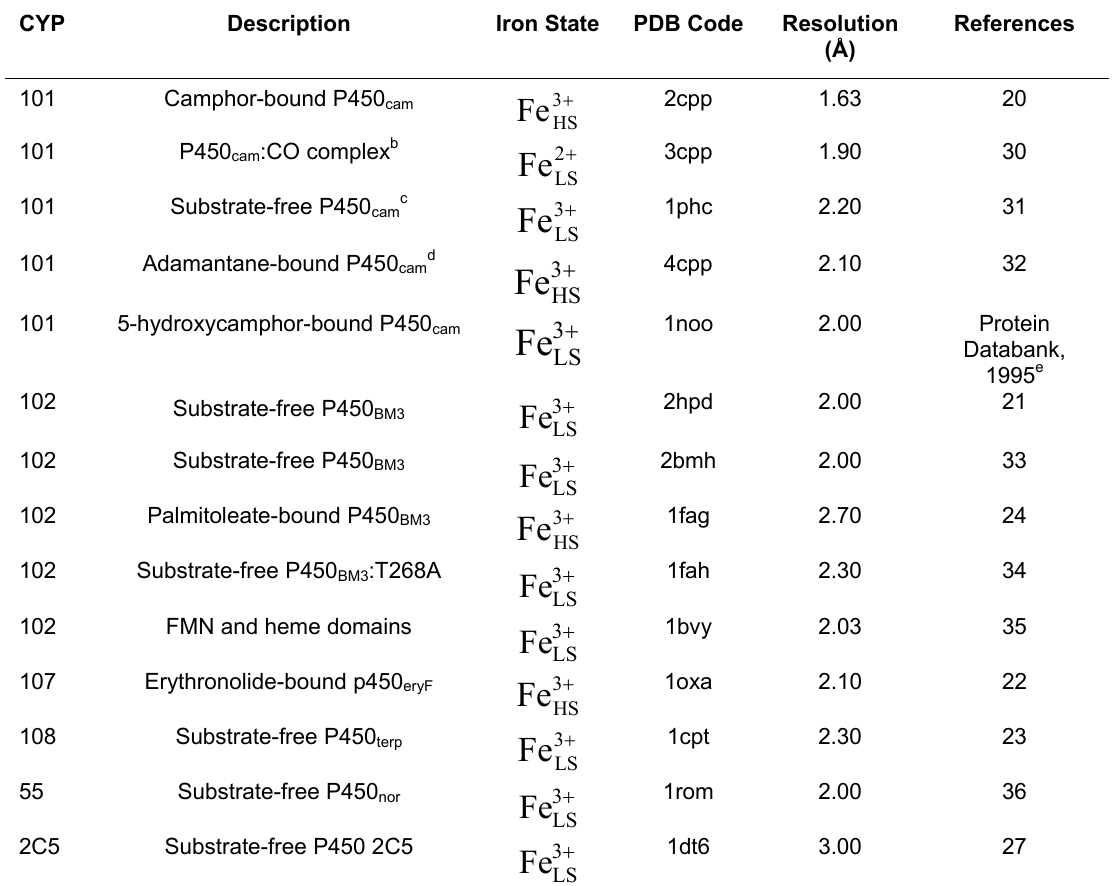
Structurally Characterised P450s